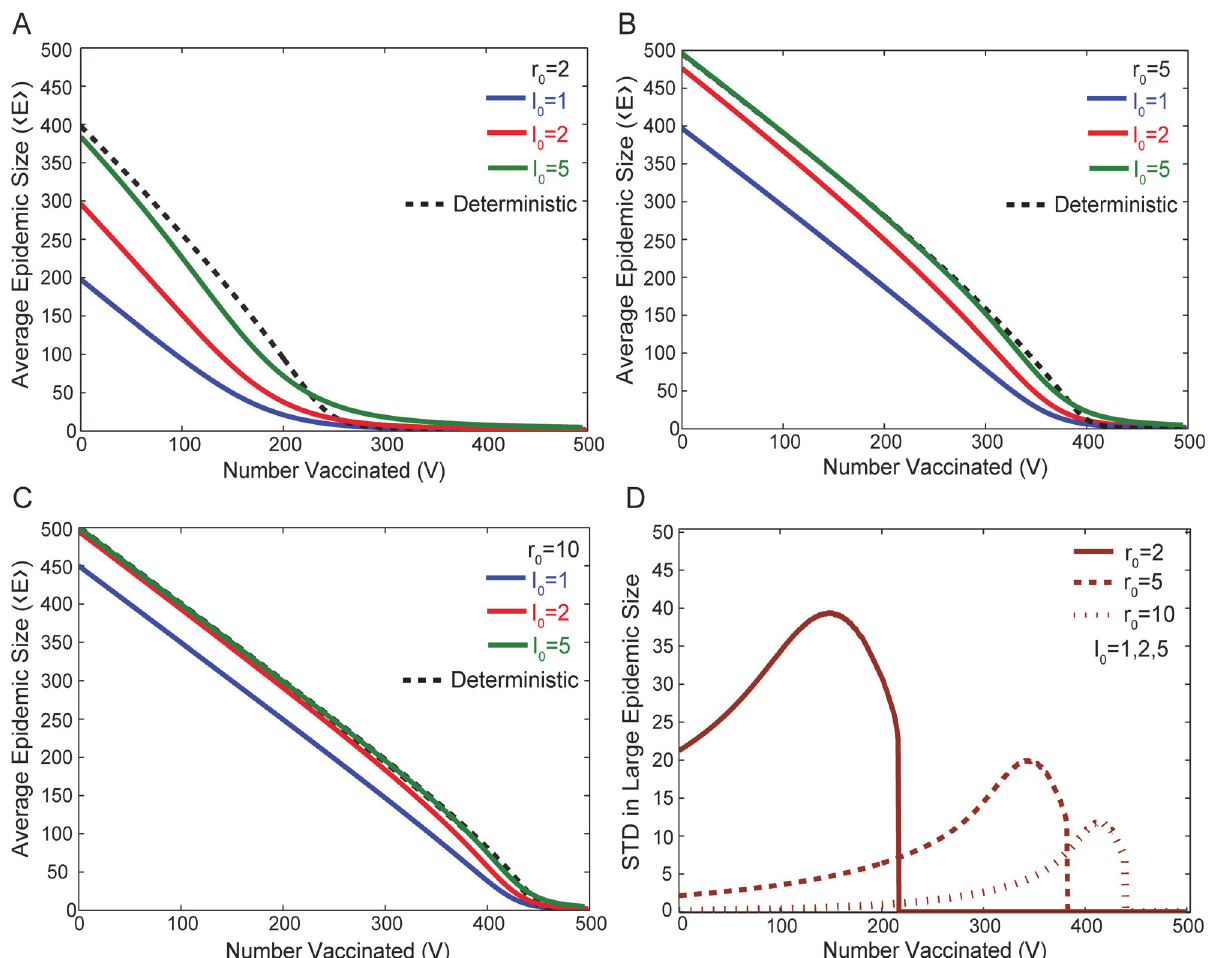
Fig 2. Comparison of the effects of vaccination between stochastic and deterministic models for various values of r 0 and I 0 . Figures A, B, and C illustrate the epidemic size as a function of the number of individuals vaccinated V . For each value of r 0 , the solid lines shows the average epidemic size h E i = R P ( E ) × E dE , and dashed lines represent the corresponding deterministic epidemic size E . The deterministic solution does not depend significantly on I is computed with I 0 = 1. Figure D illustrates the standard deviation in the large-scale epidemic for various values of r 0 . Results are independent of I 0 for the range of I 0 shown. While the average epidemic size decreases monotonically with V (Figures A – C), the standard deviation of the large-scale epidemic size initially increases with increasing V (decreasing r eff ), reflecting greater variability as r eff is reduced, similar to the increase in the width of the large-scale epidemic peak with decreasing r 0 in Fig. 1A. The results obtained here are for a population of N =